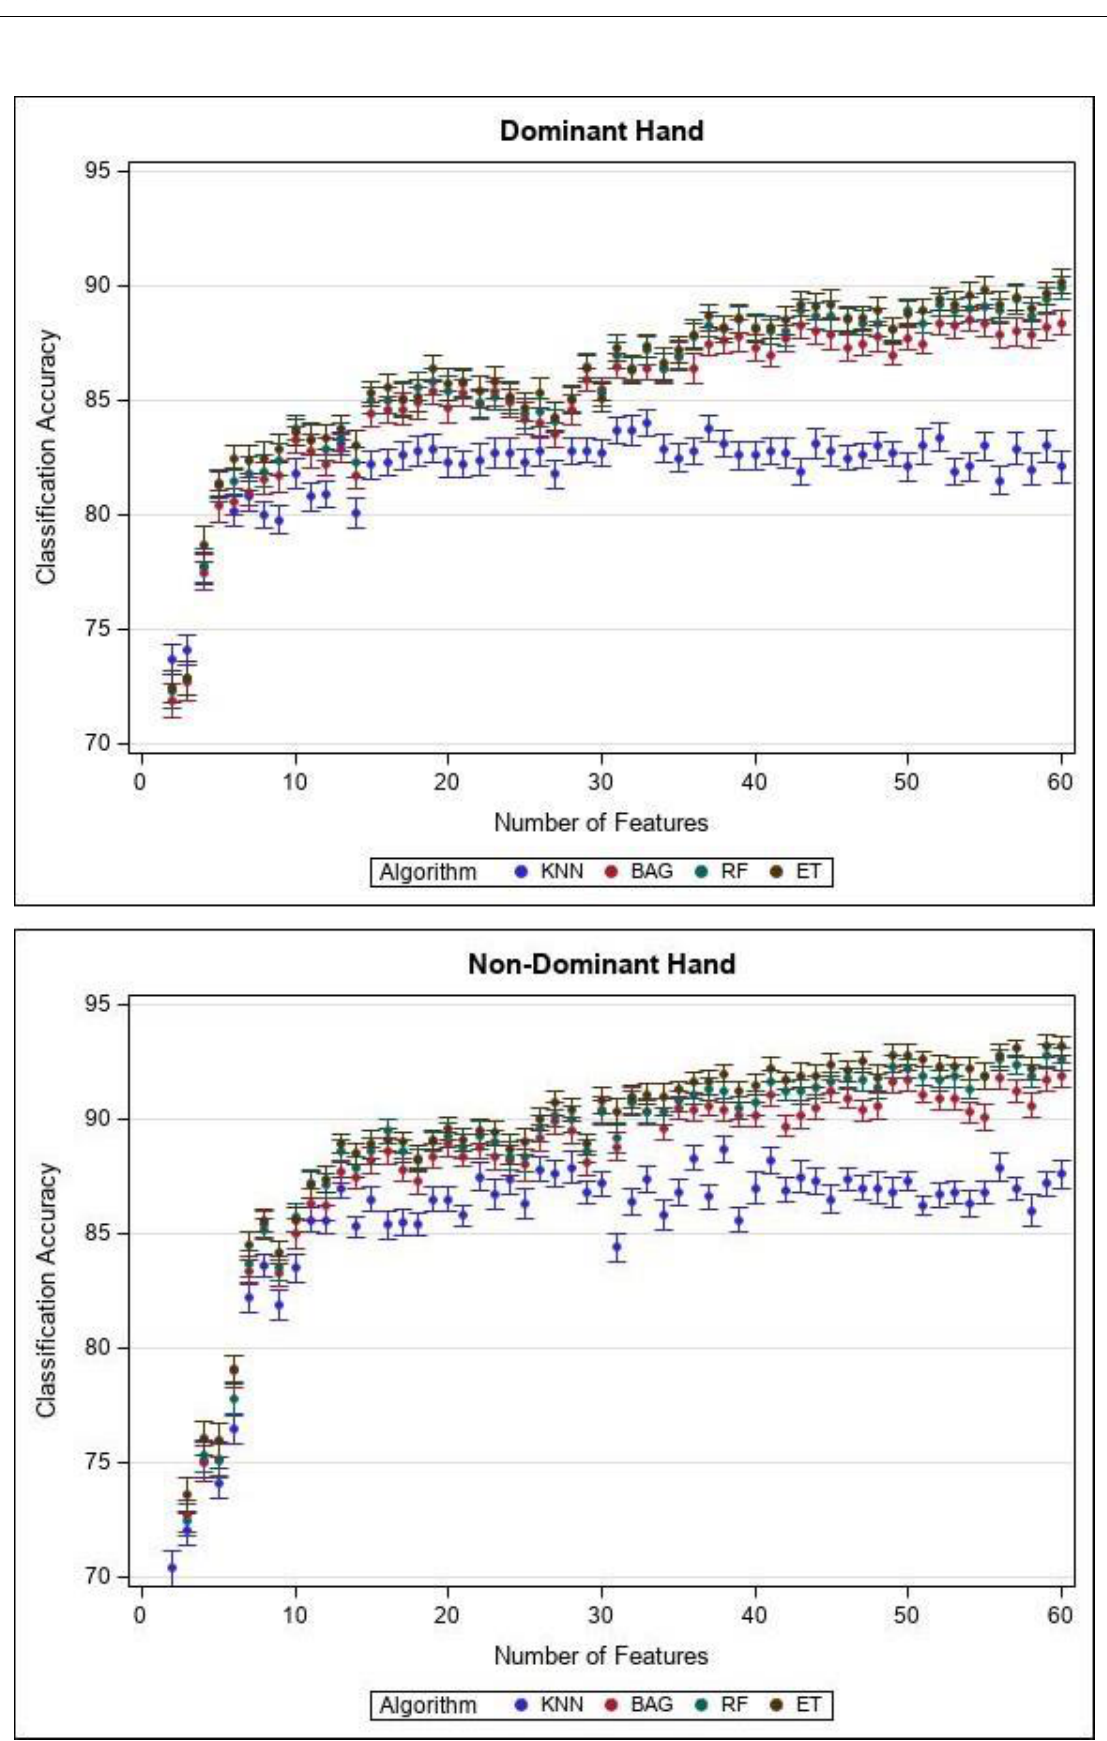
Figure 2. Accuracy and standard error for different machine learning methods and different number of selected features for dominant and non-dominant hands.